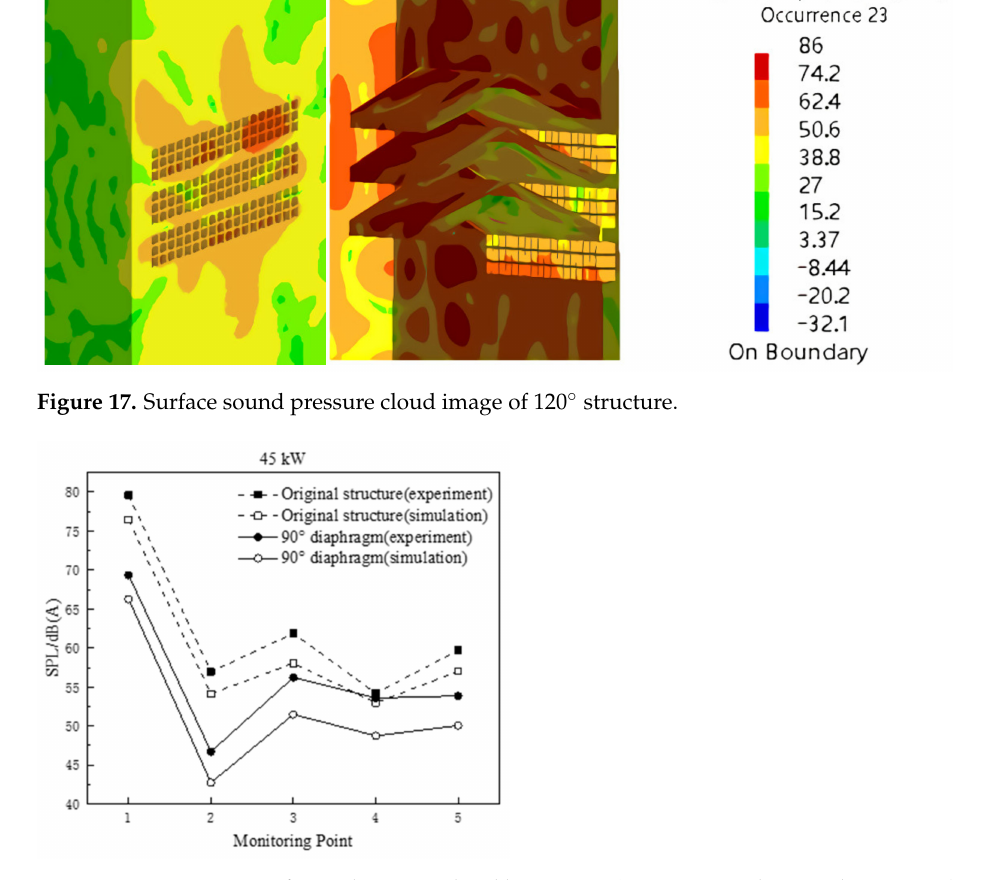
Figure 18. Comparison of sound pressure level between 90 ◦ structure and original structure (experi- ment and